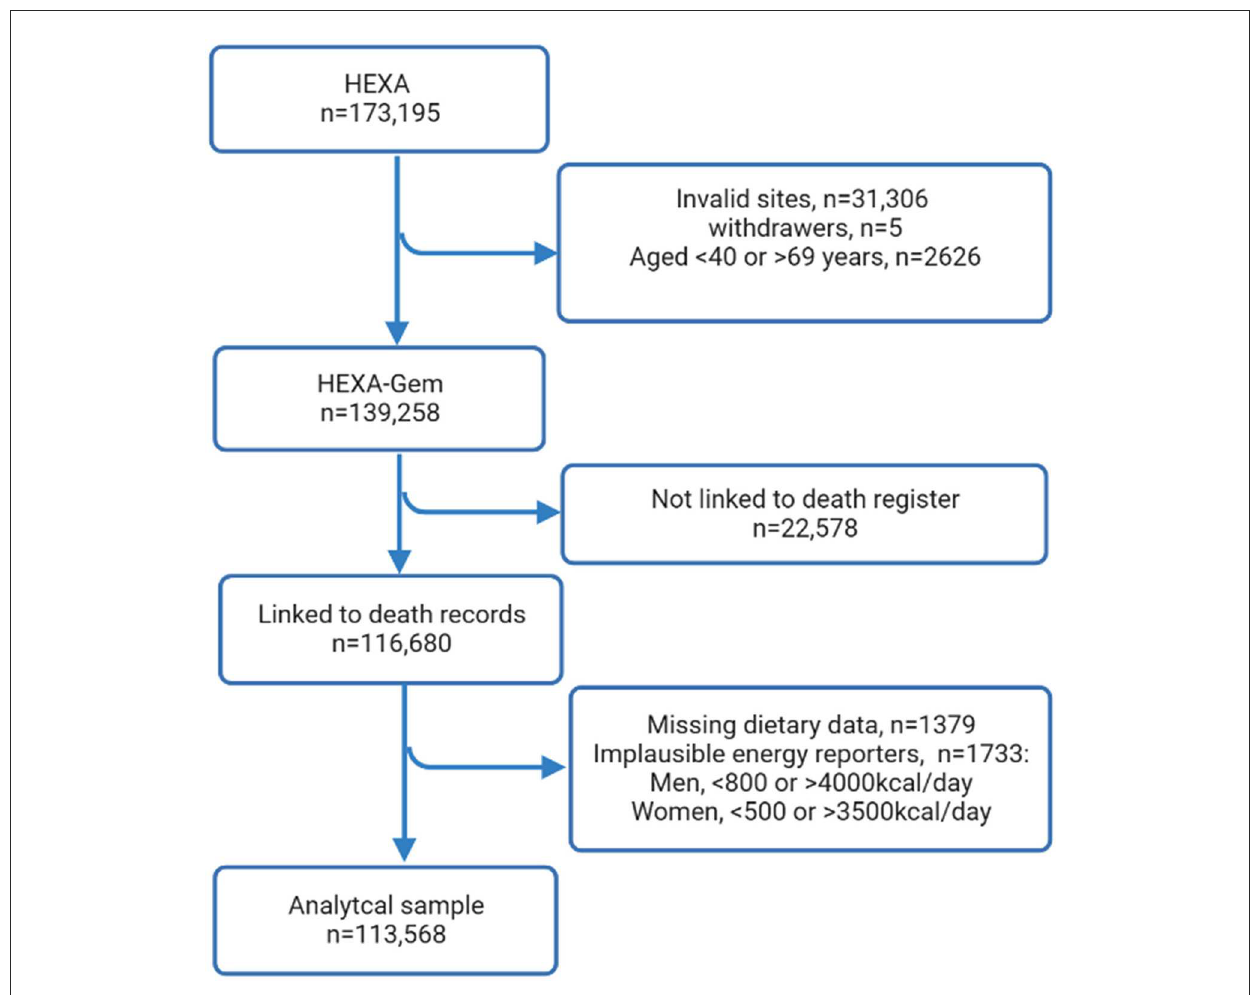
FIGURE1 Selection of study